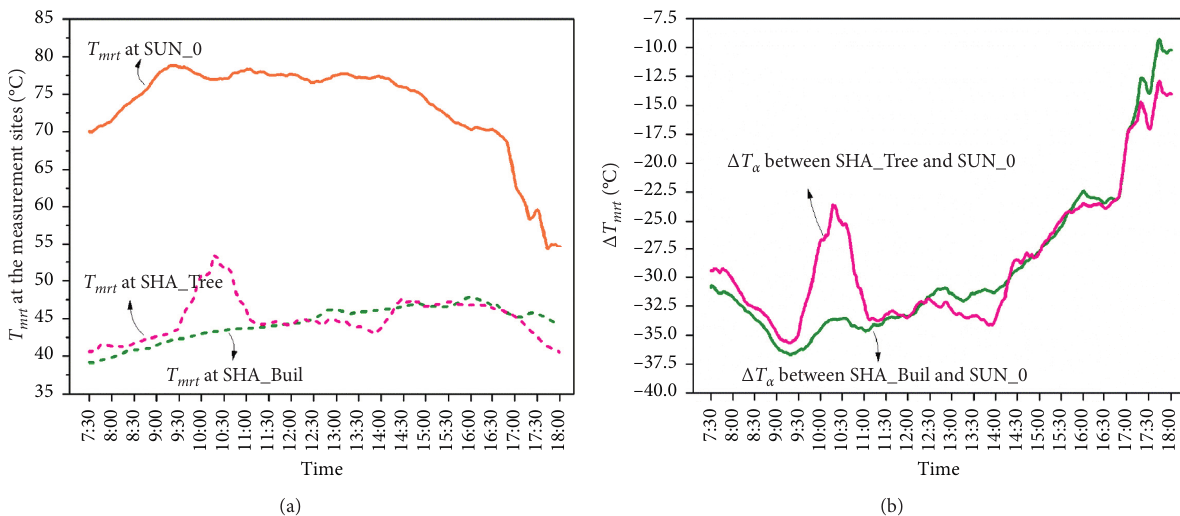
Figure 6: Diurnal patterns of T mrt and Δ T mrt on July 29, 2018: (a) temporal variation in T mrt at the shaded and sunlit areas; (b) Δ T mrt between the two shaded and the sunlit background meteorological areas.